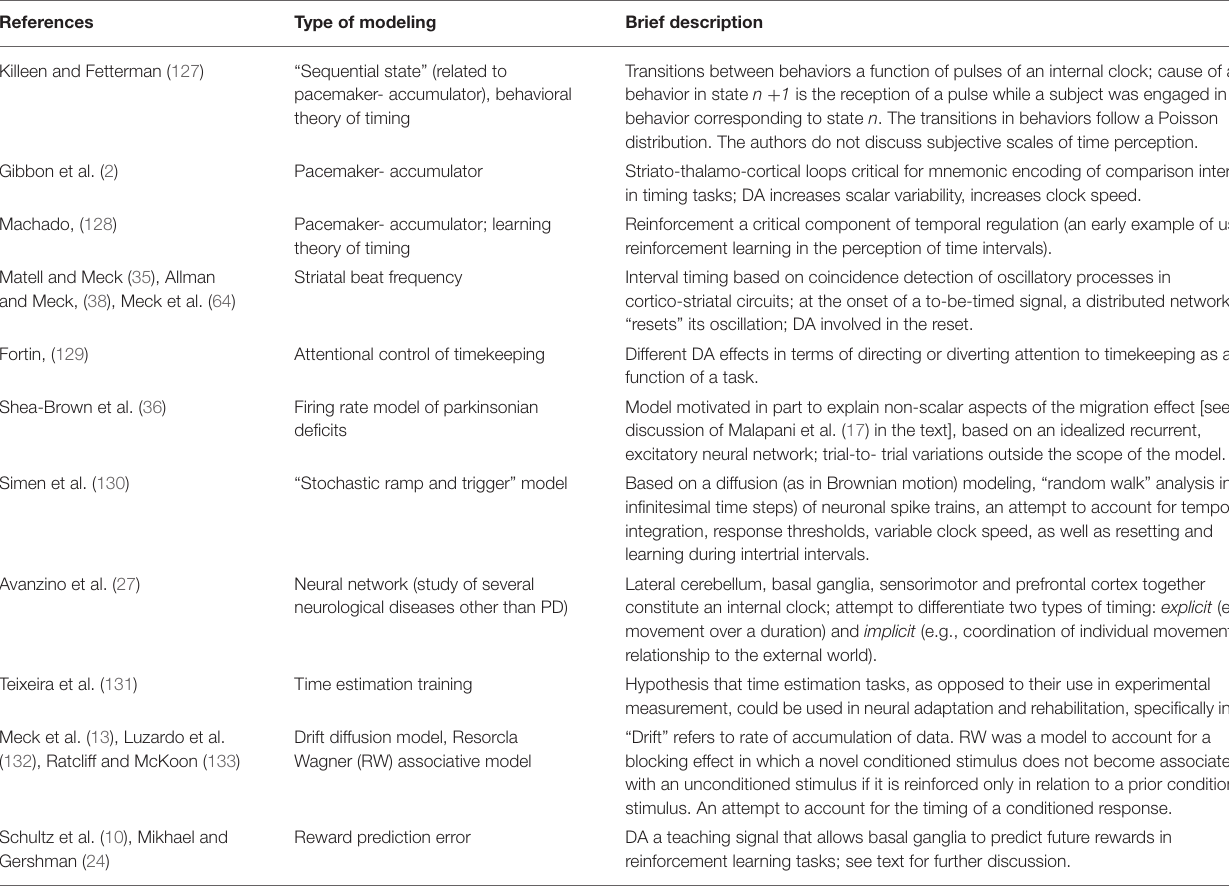
TABLE 2 | Summary of theories in DA-and-timing